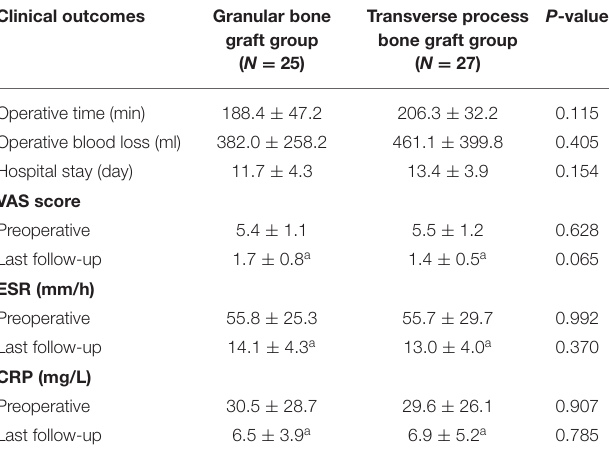
TABLE 4 | Comparison of neurological function (ASIA grade) between the two